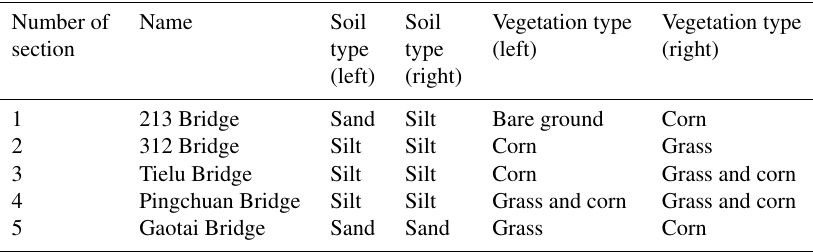
Table 2. The soil types and vegetation types over both sides of the five selected sections used in simulations. Number of Name Soil Soil Vegetation type Vegetation type section type type (left) (right) (left) (right) 1 213 Bridge Sand Silt Bare ground Corn 2 312 Bridge Silt Silt Corn Grass 3 Tielu Bridge Silt Silt Corn Grass and corn 4 Pingchuan Bridge Silt Silt Grass and corn Grass and corn 5 Gaotai Bridge Sand Sand Grass